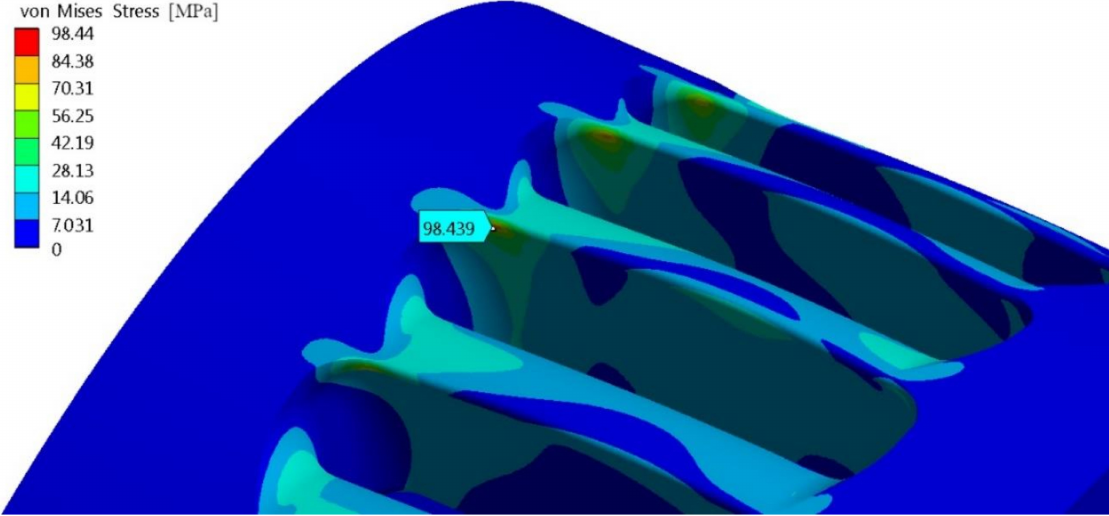
Figure 21. von Mises stress for the proposed